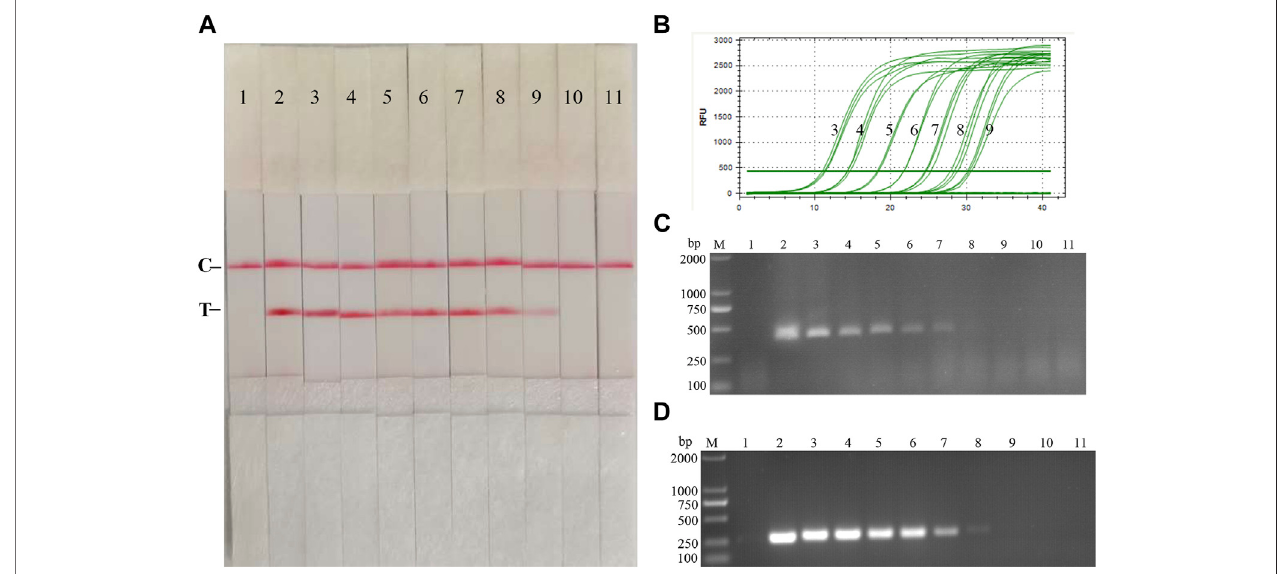
FIGURE 4| Recombinant plasmids sensitivity analysis ofASFV RAA-strip. (A) The sensitivity test result of plasmid copy number by ASFV RAA-strip in order. (B – D) are that bythe quantitative fl uorescent PCRassay, the RAAagarosegel electrophoresis assay, and the conventional PCR assay. Cisa control line.T isatest line.M isa 2,000 bp DNA marker. The copies of templates used in lane 1 – 11 successively are negative control, 10 10 , 10 9 , 10 8 , 10 7 , 10 6 , 10 5 , 10 4 , 10 3 , 10 2 , and 10 1 copies/ μ L.